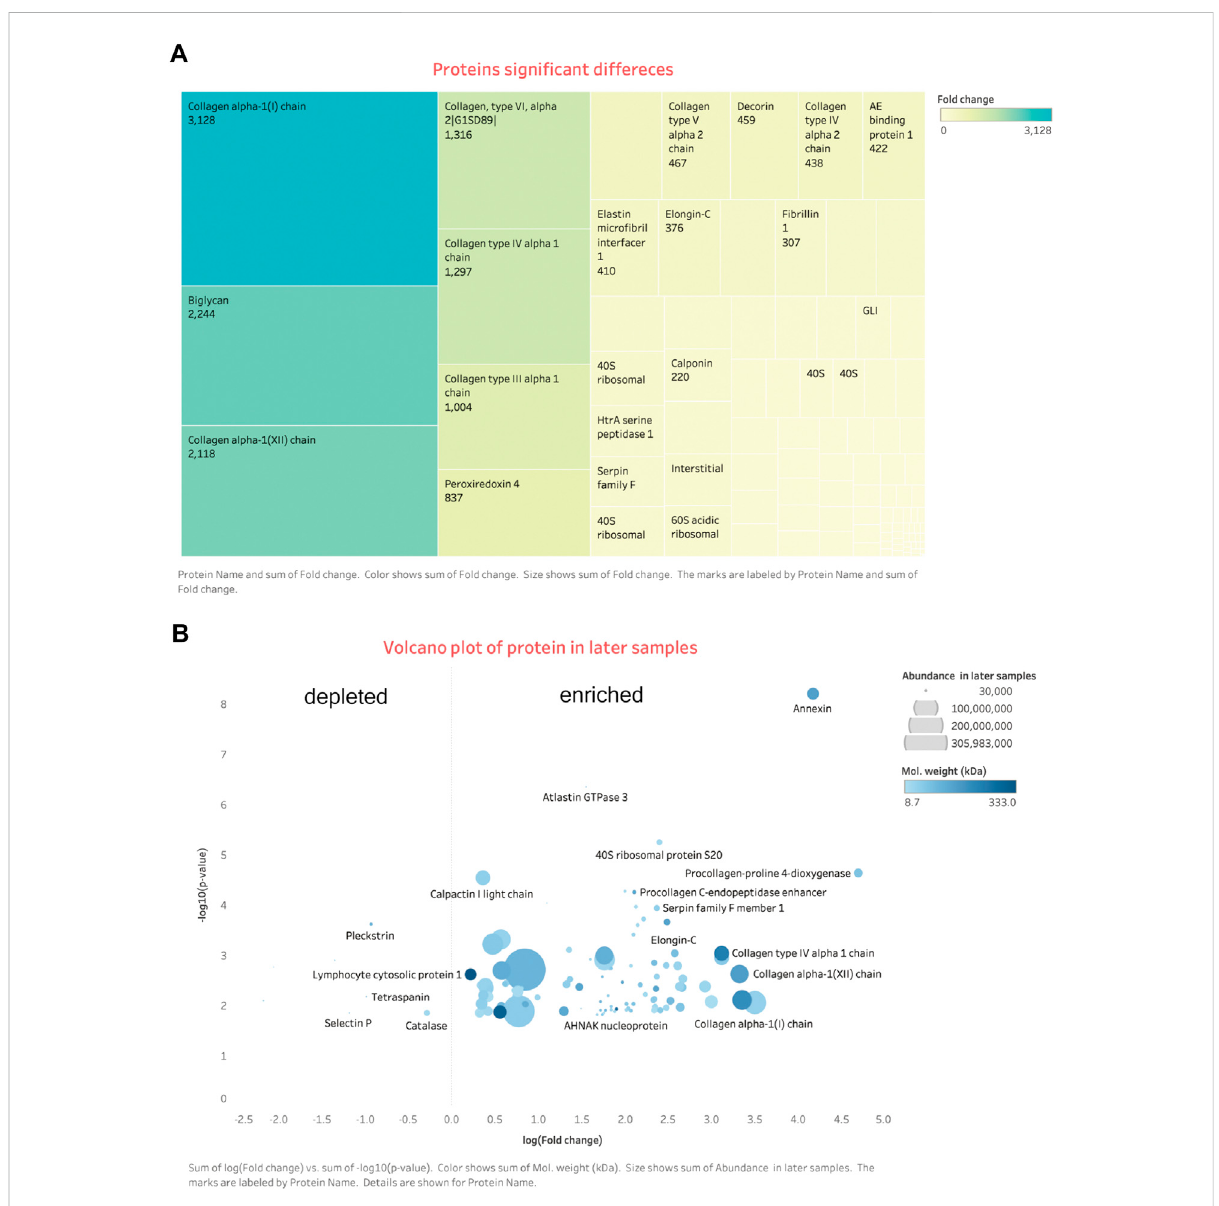
FIGURE 6 Differential expression proteins. (A) Tree map: shows most enriched proteins are the ECM related. (B) Volcano plot: on the right side are the enriched proteins, left are the depleted. More details signs are in the bottom of the fi gure.